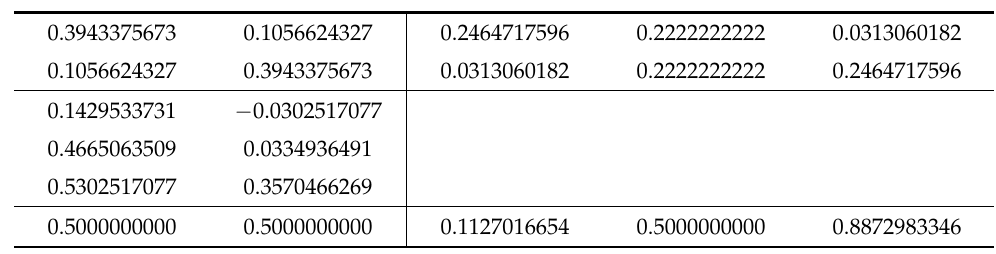
Table A13. G2|G3 method.